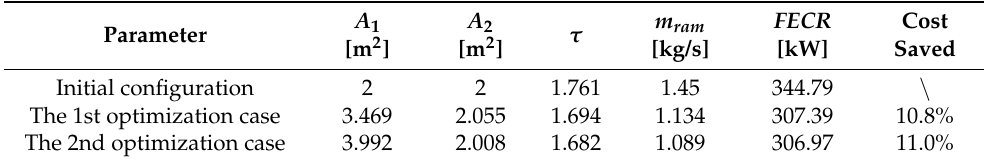
Figure 5. Comparison between the modified GA and standard GA. Table 6. Initial and optimal systematic